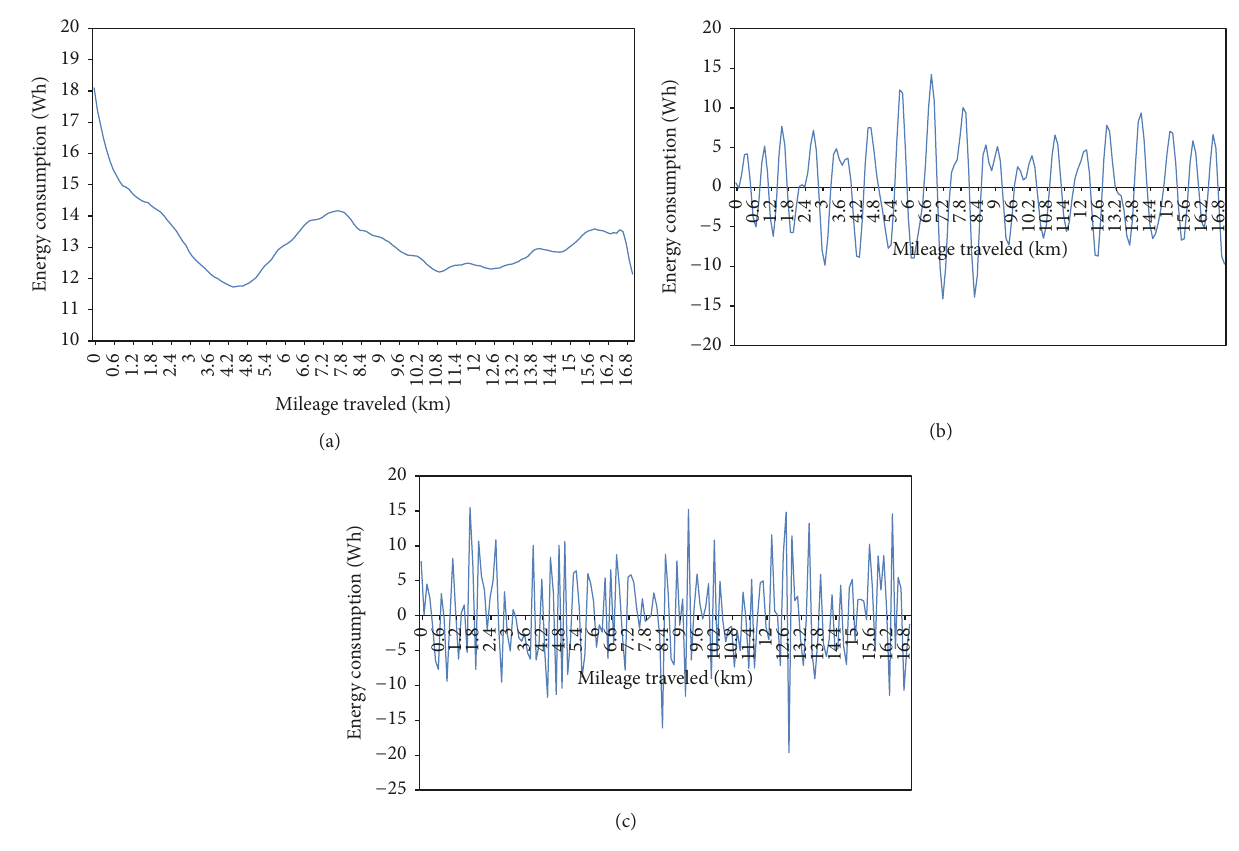
Figure 10: Reconstructed trend (a), harmonic (b), and noise